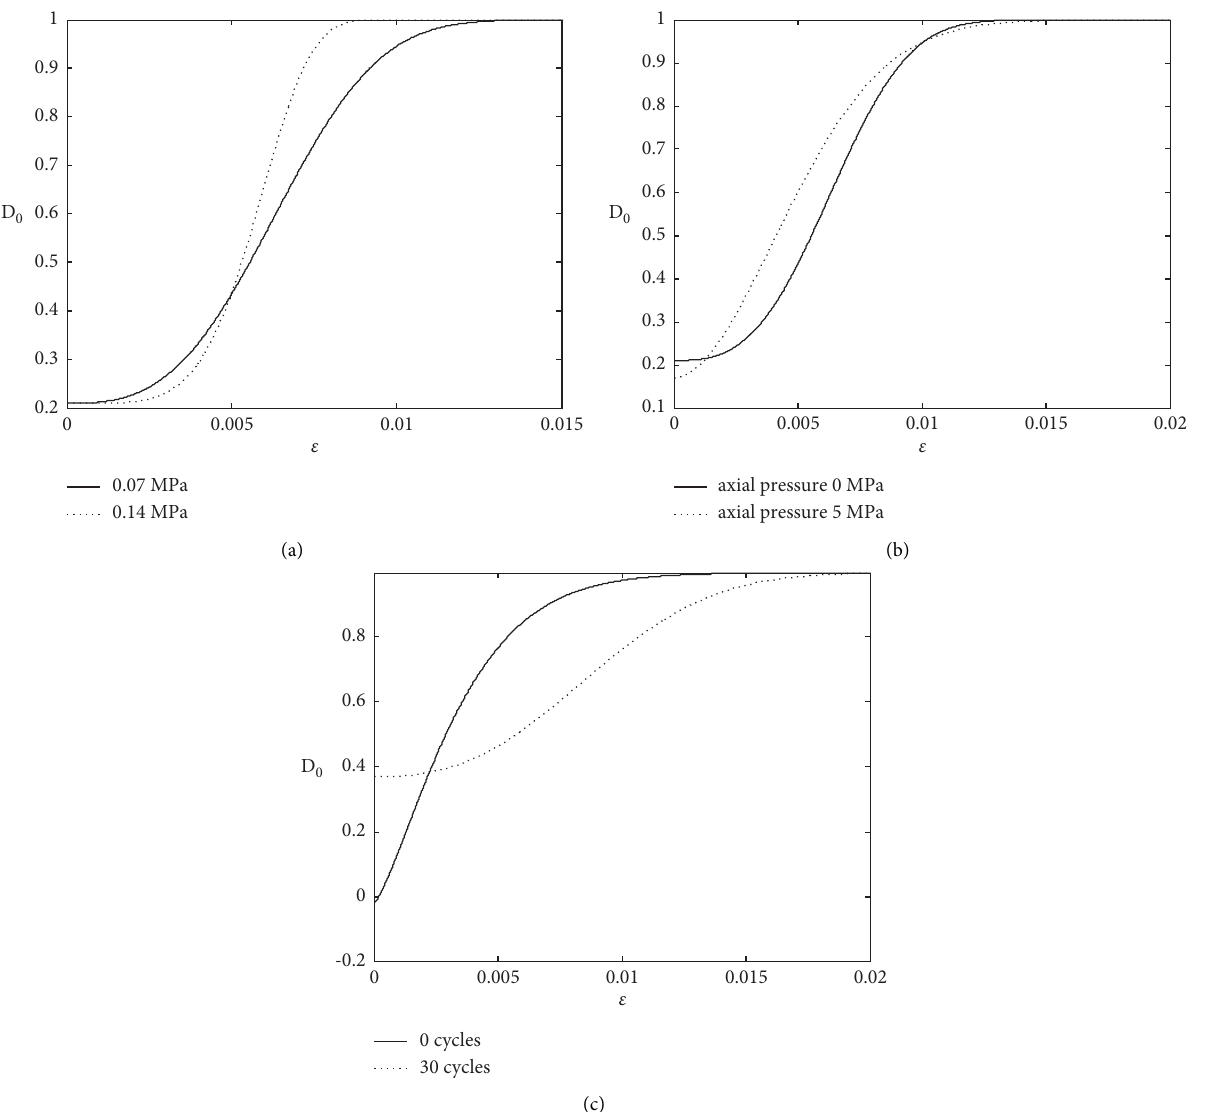
Figure 16: Typical comparison chart of the development trend of freeze-thaw rock damage variables under dynamic and static combined load. (a) Axial compression 0MPa and 10 cycles. (b) Air pressure 0.07 MPa and 10 cycles. (c) Axial compression 5 MPa and air pressure